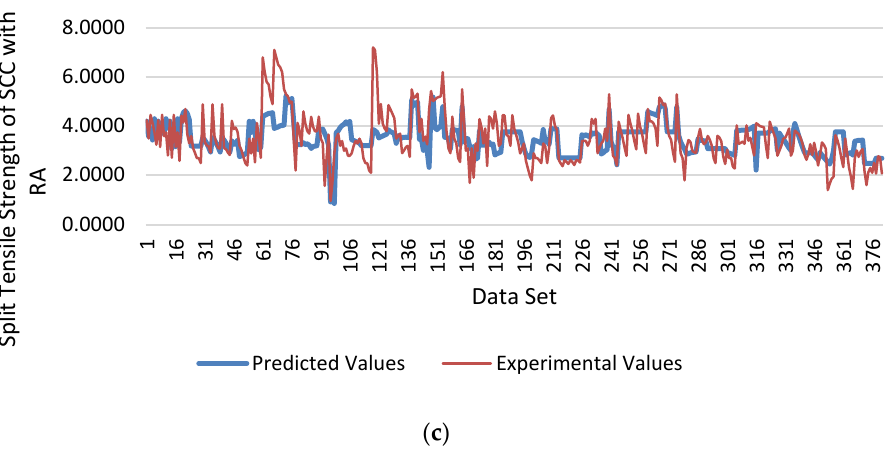
Figure 15. Comparison of experimental and predicted values by ANN of ( a ) LM, ( b ) BR, and ( c ) SCGB algorithms.